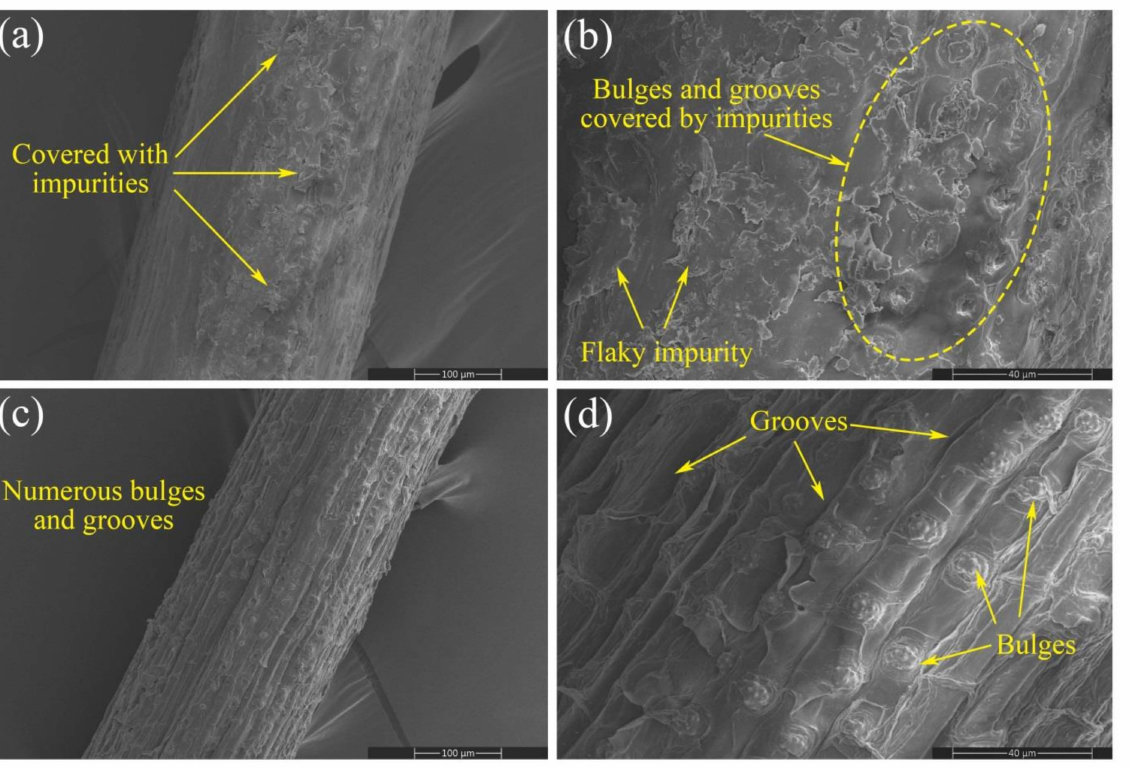
Figure 10. SEM micrographs of coir fiber surfaces: ( a ) untreated fiber (200 × ), ( b ) untreated fiber (800 × ), ( c ) treated fiber under optimal conditions (200 × ) and ( d ) treated fiber under optimal condi- tions (800 ×